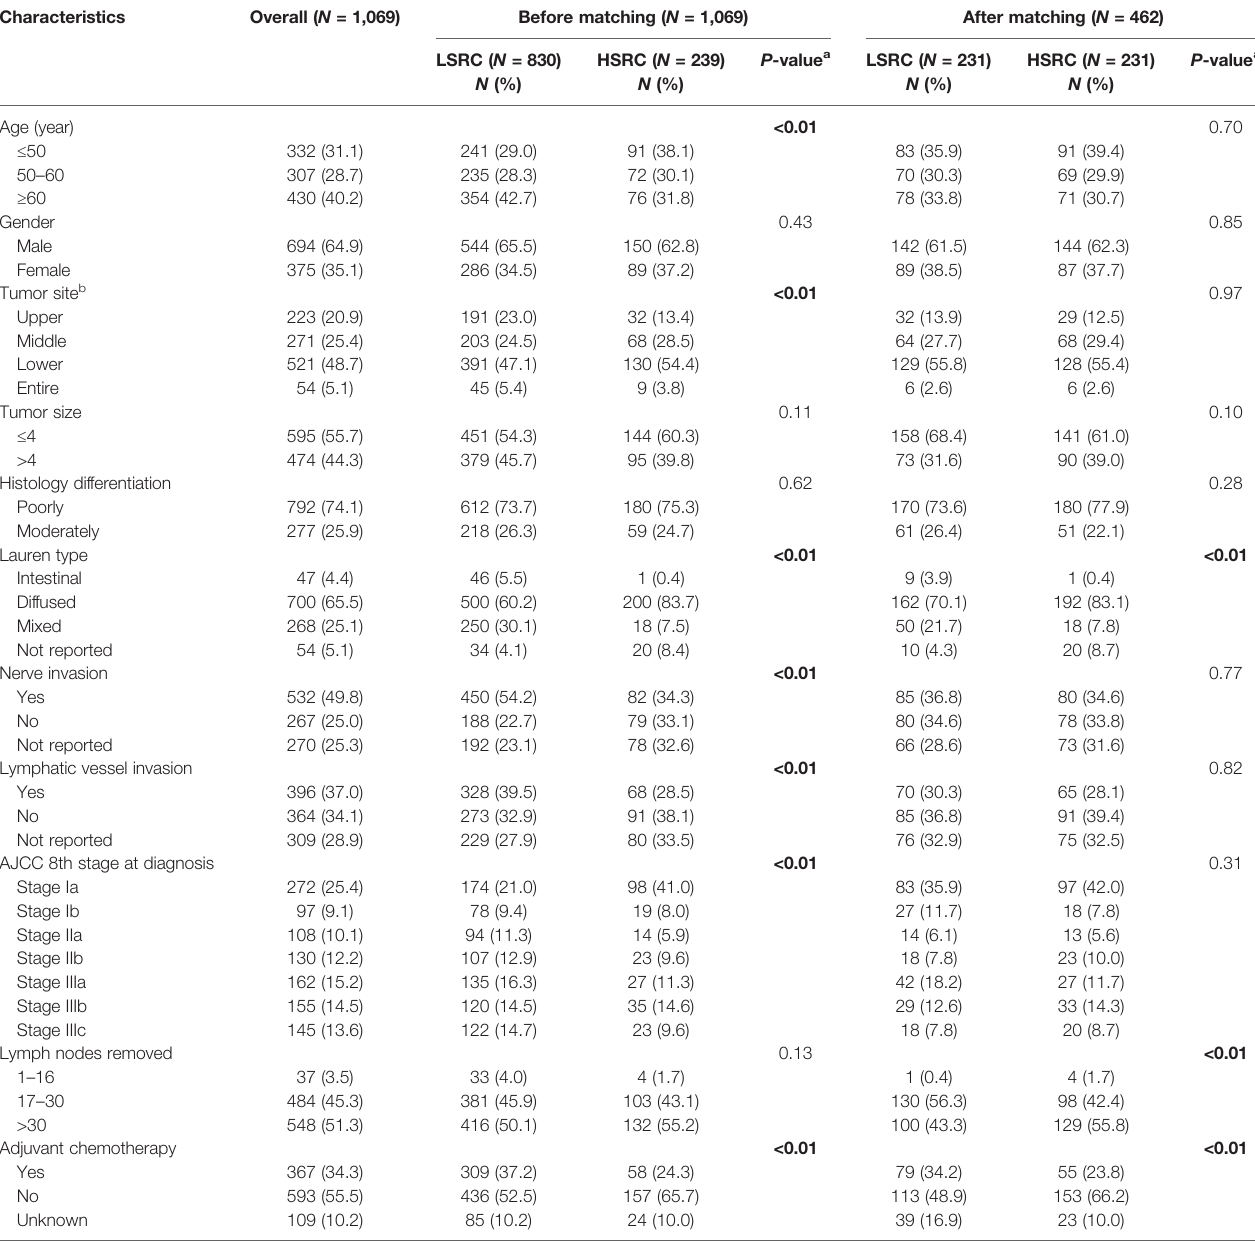
TABLE 1 | Characteristics of 1,069 stages I – III gastric cancer patients.